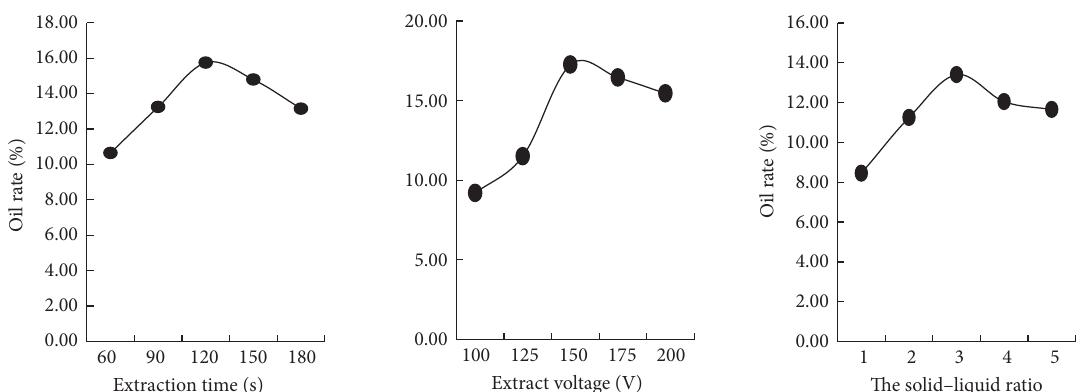
Figure 1: Influence of different factors on extraction rate of palm seed oil by the flash extraction